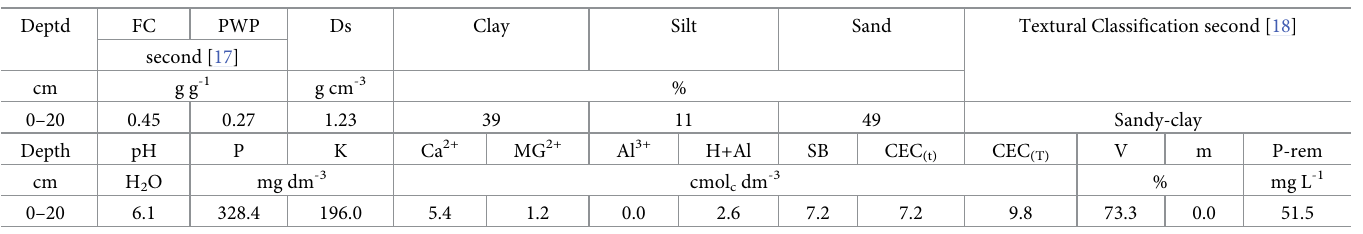
Table 1. Soil physical-hydrological and chemical analyses, according to